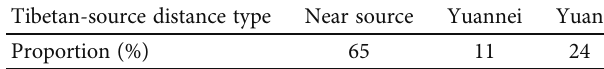
Table 2: Statistics of Tibetan-source distance in Upper Paleozoic.